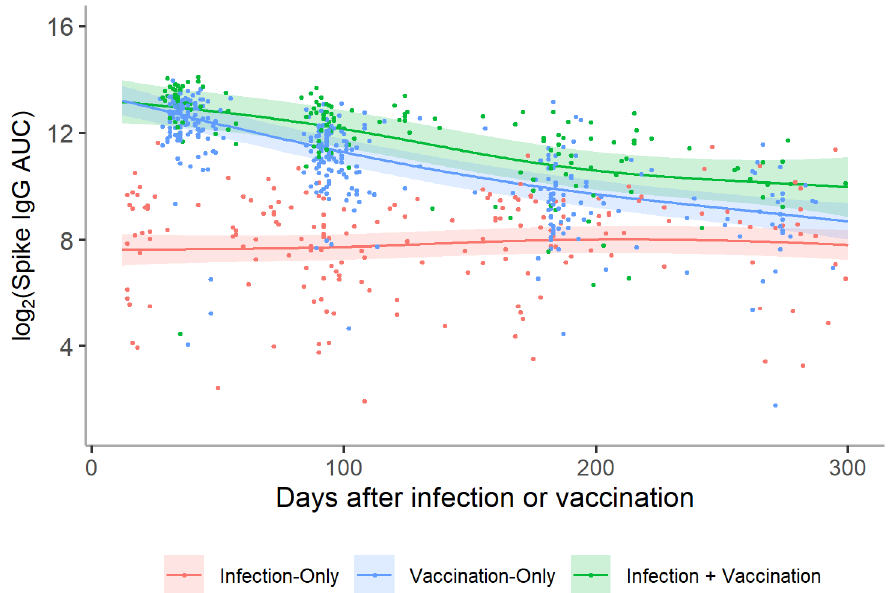
Figure 2. Log 2 anti-spike IgG titers over time for participants in the infection-only, vaccination-only, and infection + vaccination groups. A distinct smoothing function was fit for paired samples from the infection-only ( n = 201), vaccination-only ( n = 346), and infection + vaccination ( n = 162) groups using a generalized additive model (GAM). The figure represents the mean trajectory for each group marginalized over age and sex. A random intercept was also included to account for repeated measures within individuals. The two vaccine groups displayed higher titers soon after infection/vaccination compared with the infection-only group, gradually decreasing until beginning to approach the titer levels of the infection-only group approximately 300 days post-infection/vaccina- tion.